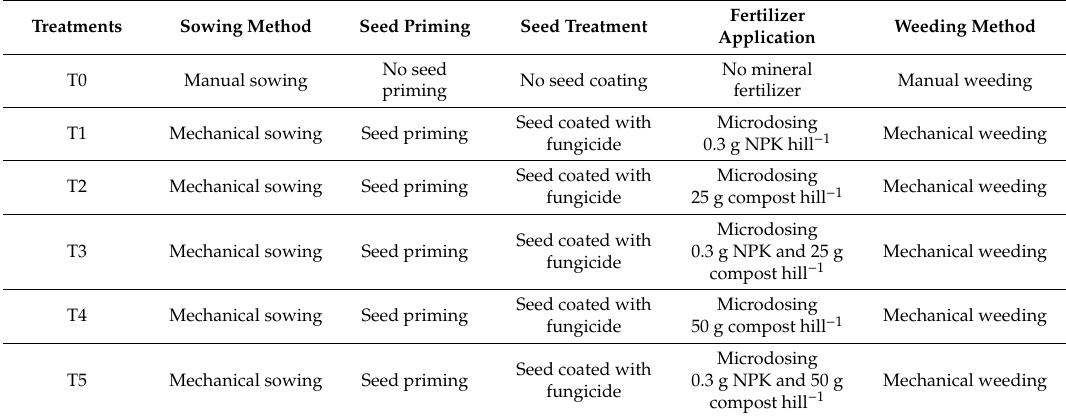
Table 1. Description of the six treatments in the on-station